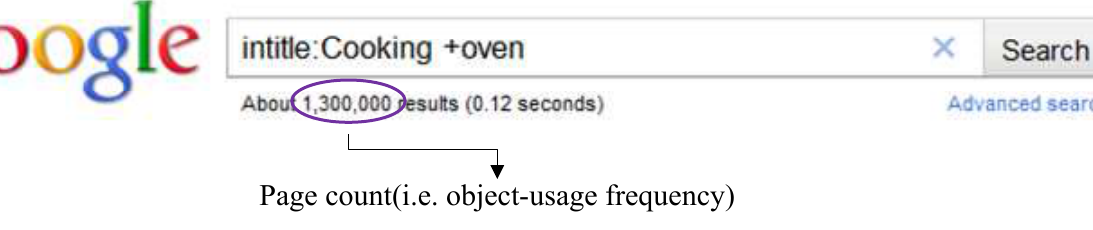
Figure 7. Object-usage frequency mining